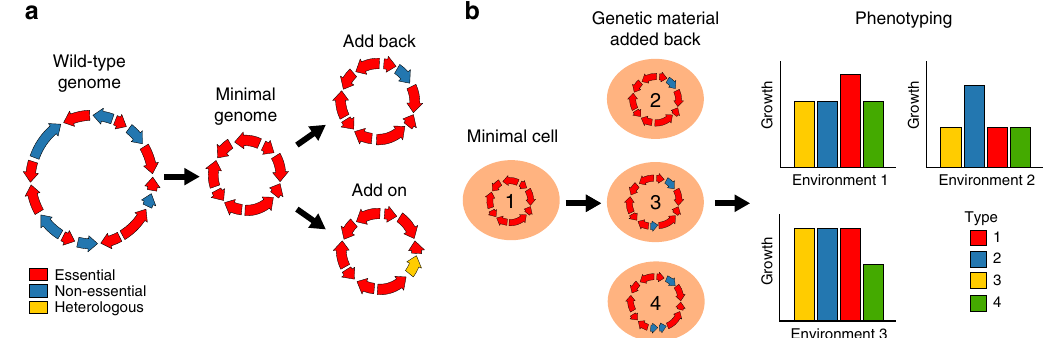
Fig. 4 Minimization. a Minimal genomes lack non-essential genes 9 . After a minimal genome has been generated, non-essential genes can be added back to explore how they impact function and phenotypic outcomes. In addition, heterologous genes (add on) can be inserted to create new cell phenotypes. b Genetic material added back to minimal genomes may help elucidate how certain genes contribute to phenotype across